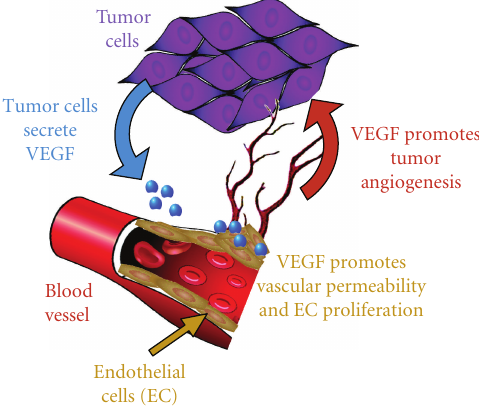
Figure 1: Molecular mechanisms of tumor-associated angiogenesis. Angiogenesis is essential for the persistence of solid tumor growth and, only recently, has it been appreciated that angiogenesis plays a role in progression of hematological malignancies as well. Cancer-associated angiogenesis in solid tumors begins once the tumor mass reaches a critical size such that the hypoxic environment inside the tumor leads to cancer cell-specific expression of proangiogenic factors including VEGF to shift the balance from endogenous antiangiogenic factors to tumor supplied proangiogenic factors—the angiogenic switch. Once proangiogenic factors overwhelm antiangiogenic factors, new blood vessels form in response to VEGF-induced endothelial permeability by EC sprouting, migration into the tumor mass, and proliferation from existing blood vessels—molecular mechanisms also induced by VEGF [64–67]. The tumor integrity of the vasculature is compromised in that it remains leaky with poor cell-to-cell adhesion, is abnormally branched and not well supported by pericytes (mural cells), the vascular smooth muscle cells that stabilize normal blood vessels [67, 68]. The chronic immaturity of tumor vessels has led Dvorak to characterize a tumor as a “wound that never heals” [69]. Notwithstanding, these features make tumor vessels viable targets for antitumor therapies. Benjamin et al. [70] demonstrated that removal of growth factors leads not only to the cessation of new vessel growth, but also to regression of the immature tumor vasculature